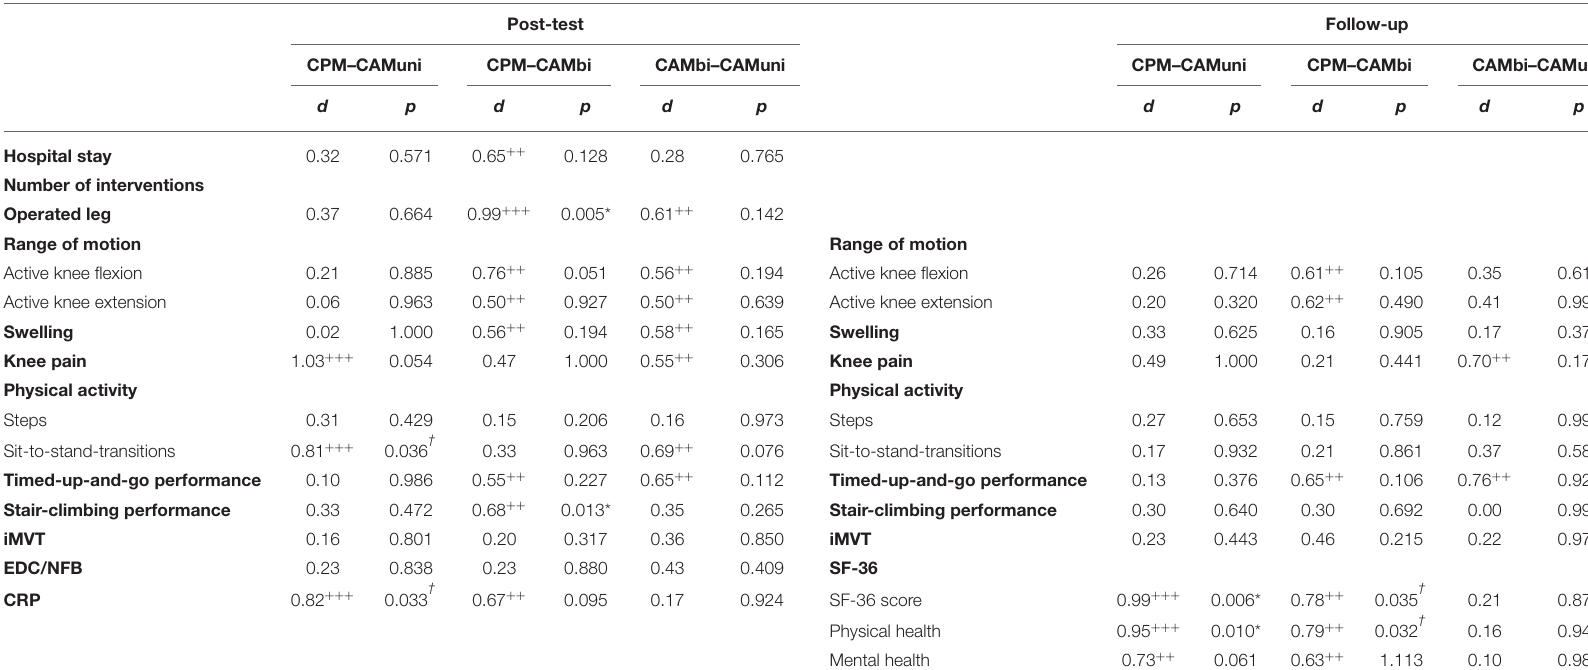
TABLE 5 | Clinical relevance (Cohen’s d effect size) and statistical significance ( p -value) for post-hoc paired comparisons between groups at post-test and follow-up (modified intention-to-treat